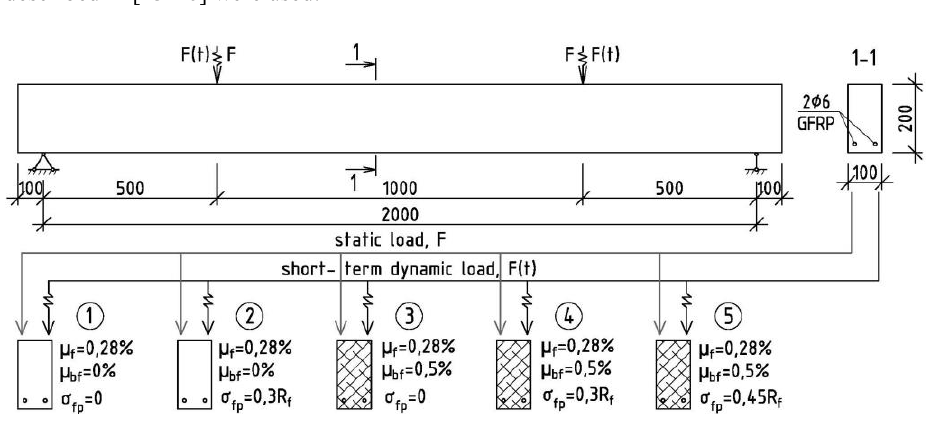
Fig. 1. The program of experimental studies of bent BFC-GFRP elements with static and short-term dynamic